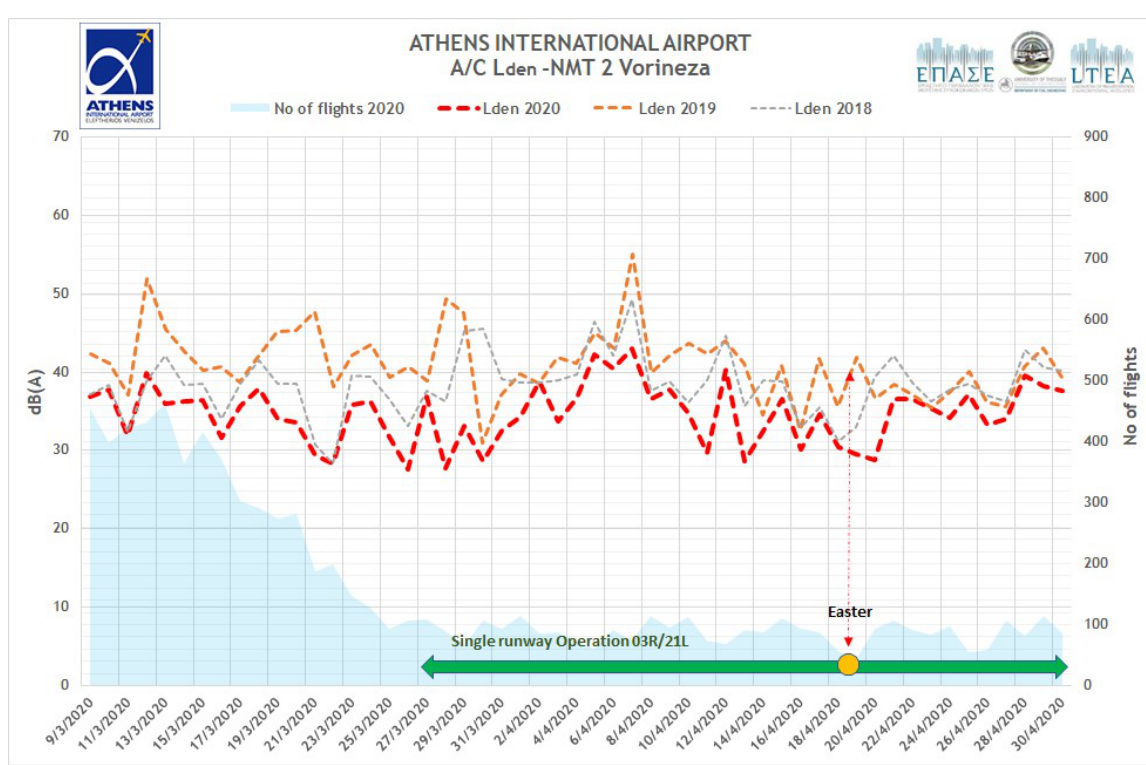
Figure 11b: Fluctuation of L den index – Noise monitoring station NMT 2